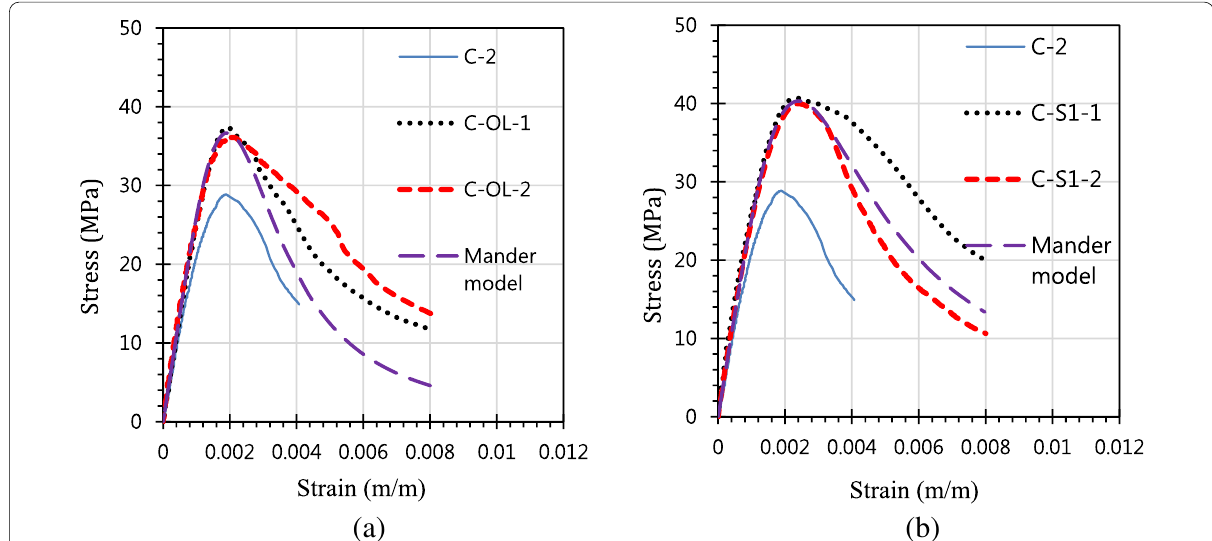
Fig. 14 Control specimen vs. Type-1 (overlap) and Type-2 (lap splice) cylindrical specimens. a Type-1: stress vs. strain; b Type-2: stress vs. strain.